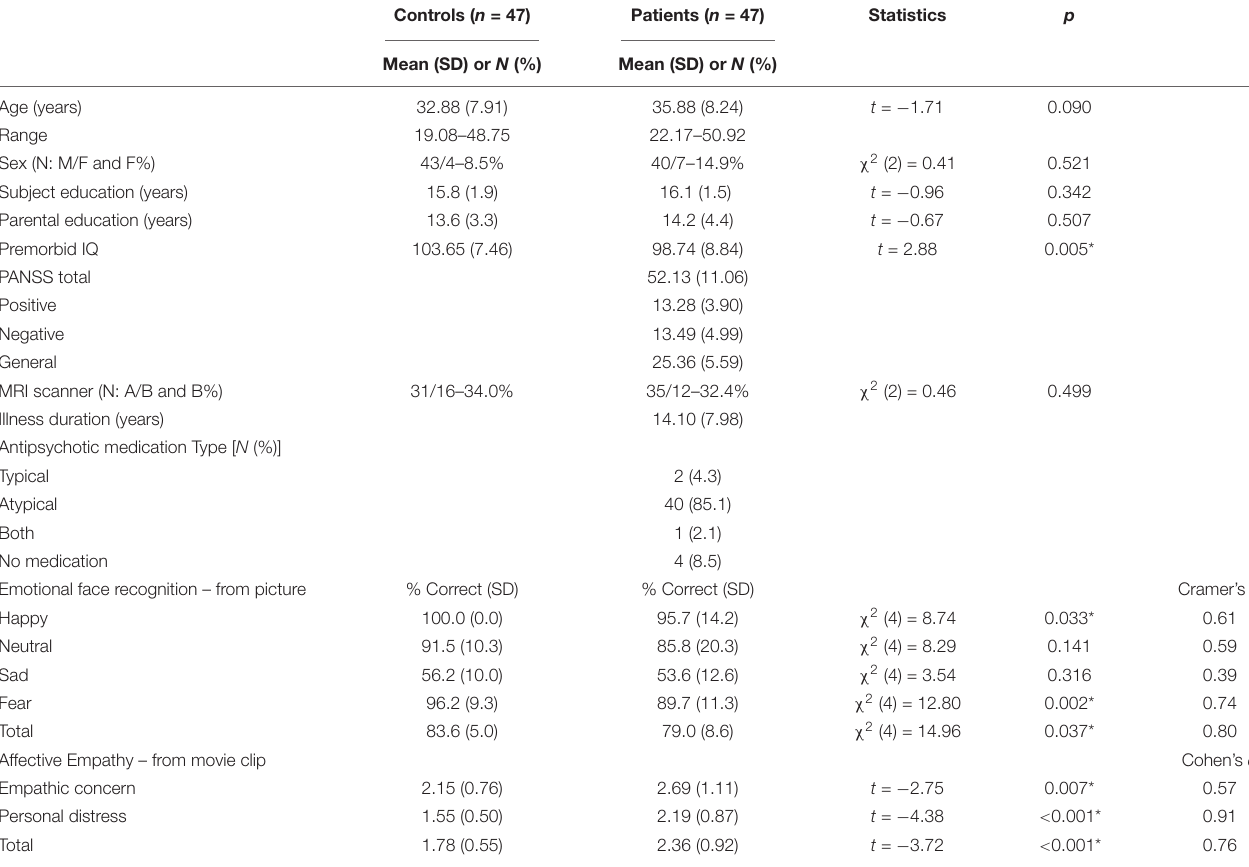
TABLE 1 | Information on demographic, clinical information and emotion processing performance for patients with schizophrenia and